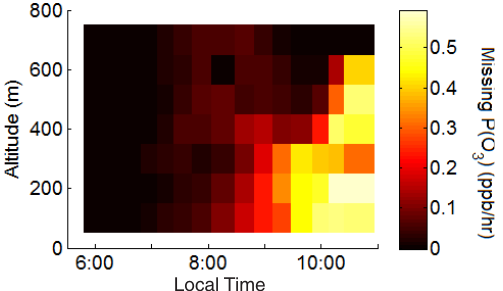
Figure 6. Underestimate in ozone production rate caused by the modeled underestimate in HCHO as a function of time and alti- tude. Missing P(O 3 ) is defined as P(O 3 ) calculated using measured HCHO minus P(O 3 ) calculated using modeled